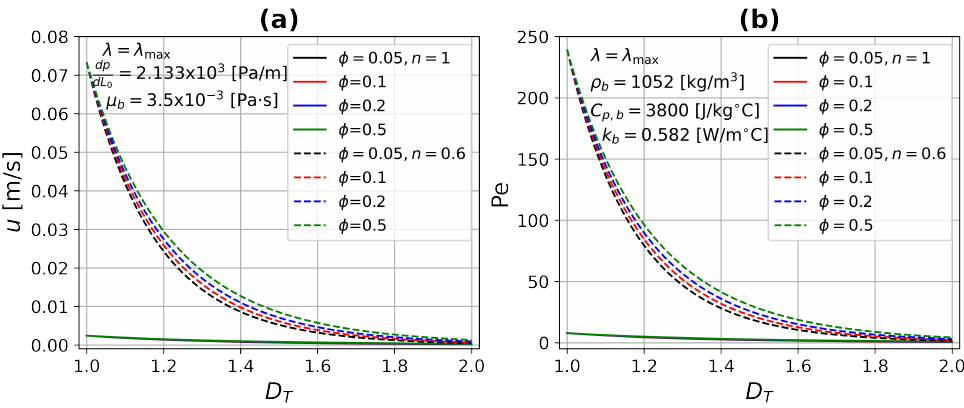
Figure 5. ( a ) Average velocity and ( b ) Peclet number as a function of fractal tortuosity D T for different porosity values. For both in a single microcapillary, continuous lines (Newtonian fluid), and dashed lines (non-Newtonian